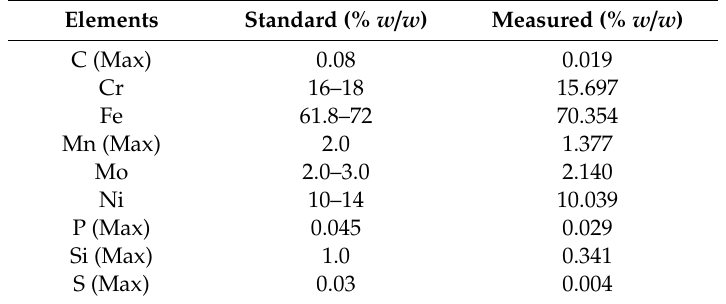
Table 1. Chemical composition of AISI 316 by optical emission spectrometry.